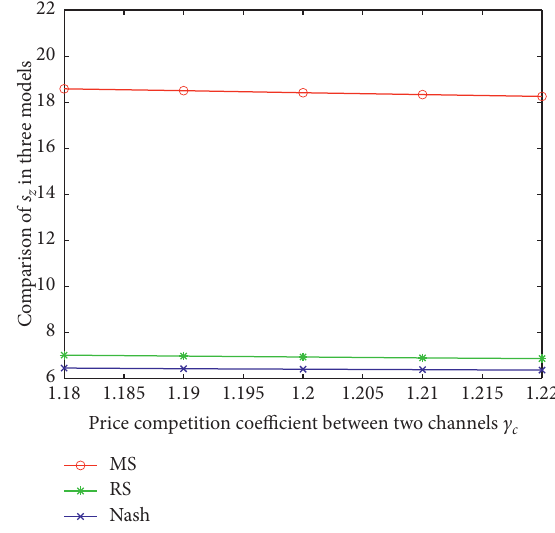
Figure 11: The comparison of the optimal service level of cus- tomized products s z in the three models.